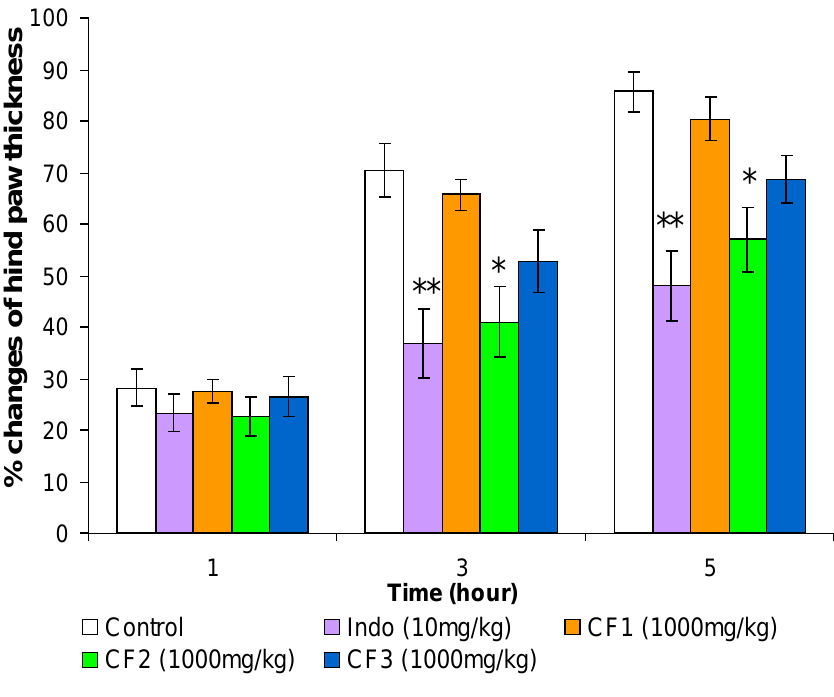
Figure 1. Effects of chloroform extract fractions of Orthosiphon stamineus leaf on carrageenan-induced rat hind paw edema (n =